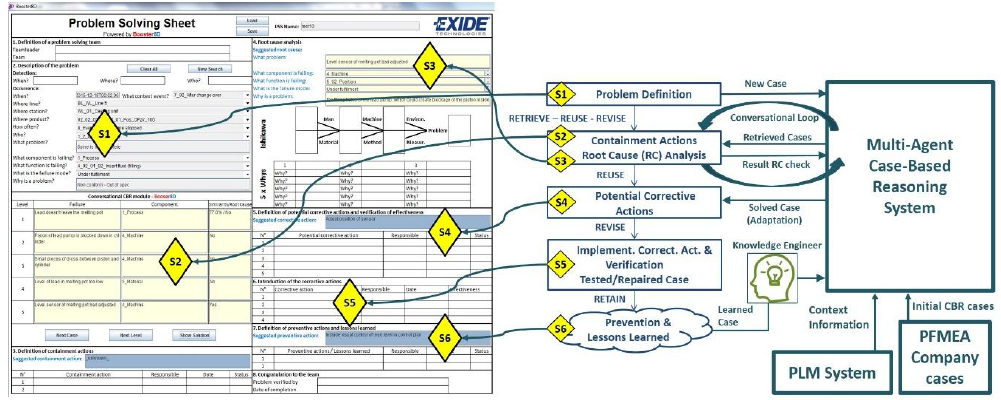
Figure 1. Process model of knowledge-based system. PLM, Product Lifecycle Management; PFMEA, Process Failure Mode and Effect Analysis; CBR, case-based reasoning.